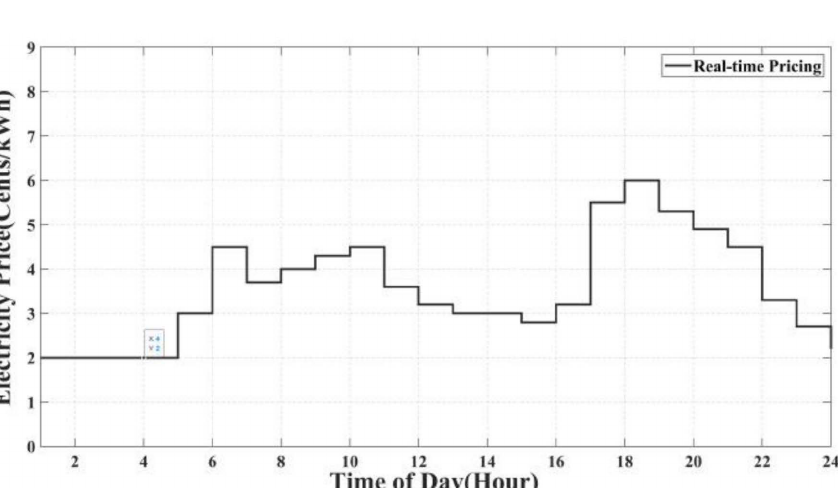
Figure 6. Real-time electricity prices curve